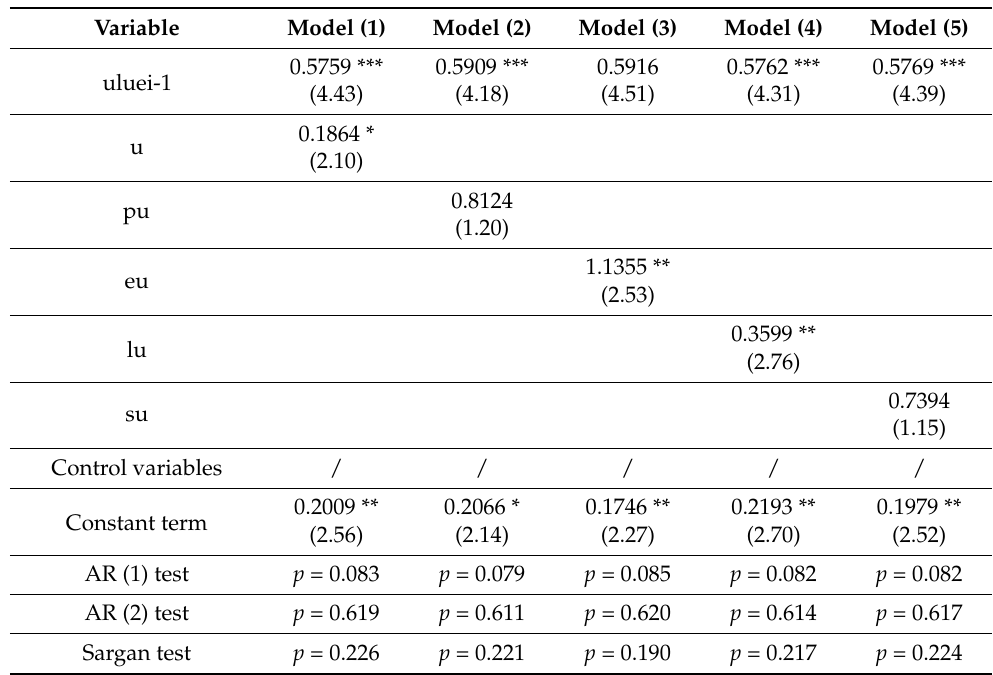
Table 7. Robustness Test—Removal of the Control